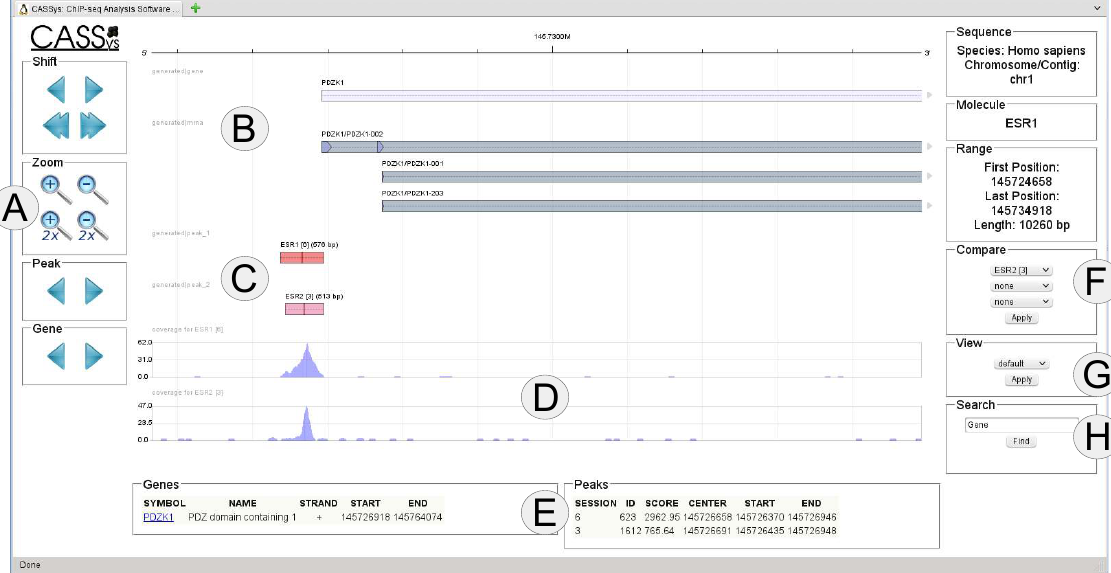
Figure 4: The CASSys ’s genome browser displaying two ChIP-seq datasets. Navigation elements provide functionality for shifting, zooming and jumping to certain features (A). Tracks display ge- nomic annotation like genes and transcripts (B). DNA-protein interaction sites of different datasets are color-coded (C). The original coverage of precipitated DNA-fragments is shown in an extra track (D). Displayed genes and interaction sites are also provided in an additional tabular view (E). Multiple datasets can be selected for visual comparison (F). The level of detail and different color-schemes of annotated genes can be chosen (G). A search box allows searching specific genes